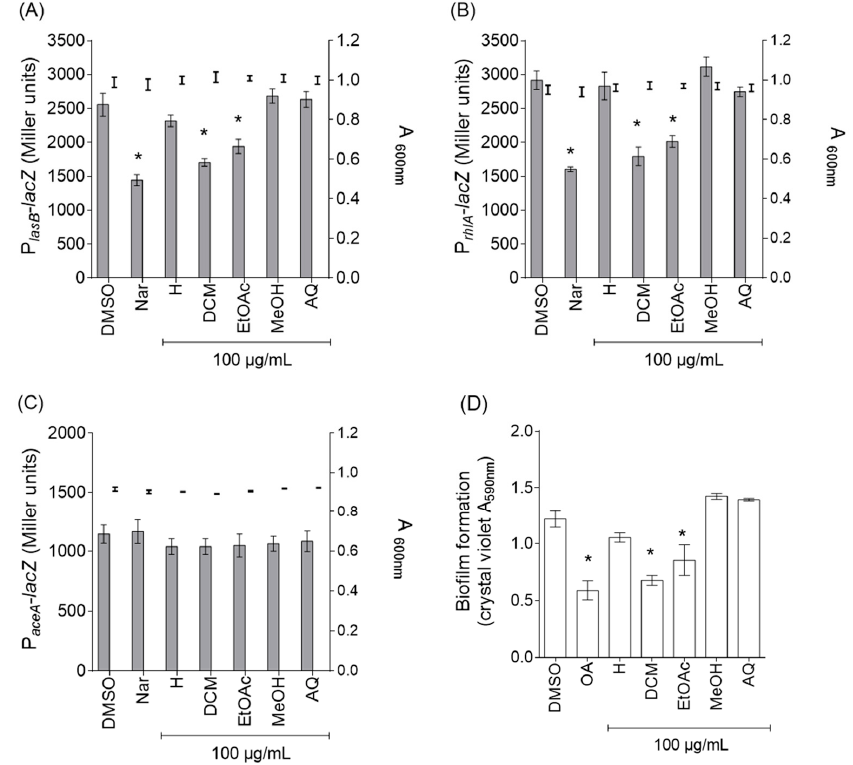
Figure 1. Anti-virulence effects of Platostoma rotundifolium extracts in P . aeruginosa PAO1: ( A ) effect of P. rotundifolium extracts on the expression of QS-regulated lasB gene; ( B ) effect of P. rotundifolium extracts on the expression of QS-regulated rhlA gene; ( C ) effect of P. rotundifolium extracts on